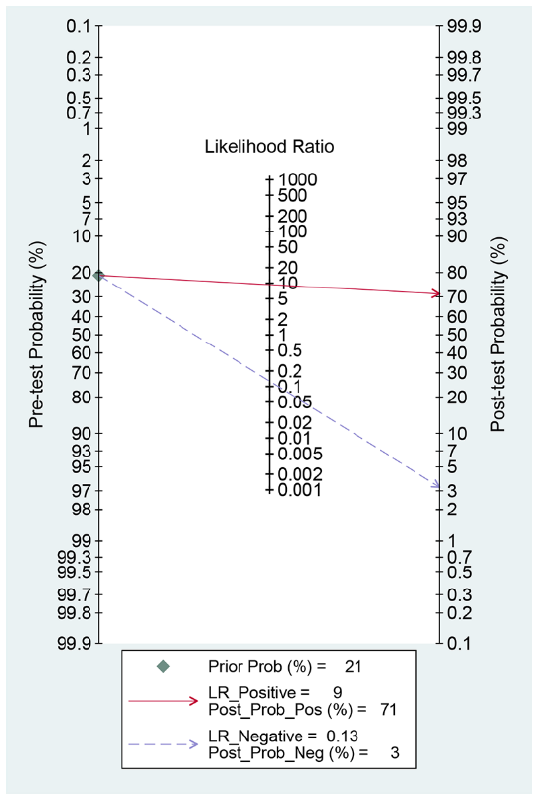
Figure 5. Fagan nomogram for the computer-aided diagnosis of gastrointestinal protruded lesions using wireless capsule endoscopy images.